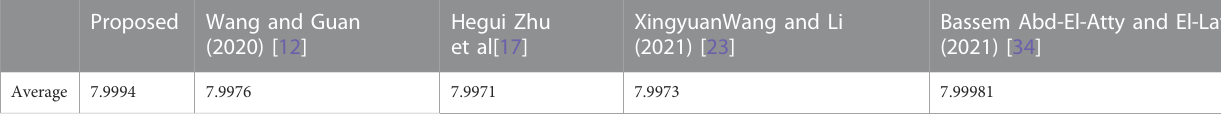
TABLE 3 Information entropy of different encryption schemes.